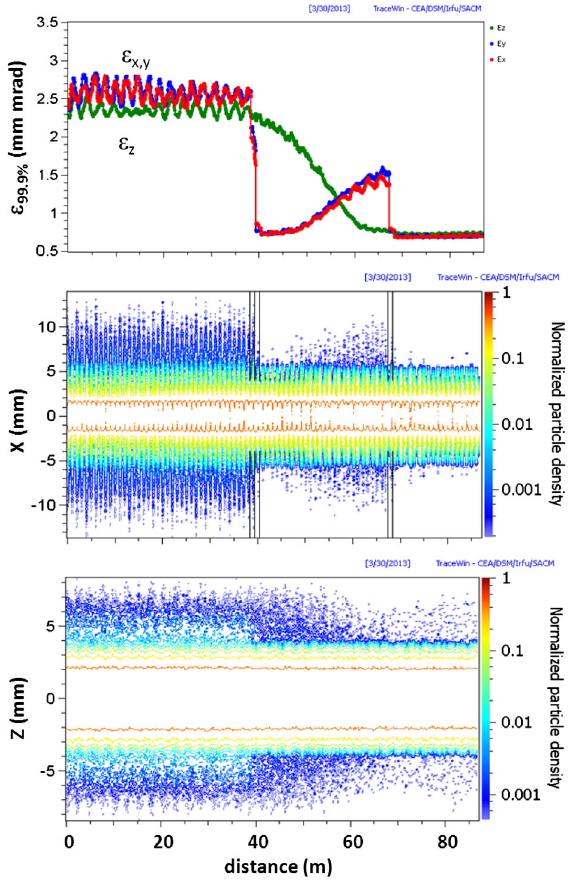
FIG. 6. Cleaning of initially isotropic halo by two consecutive transverse scrapers: 99.9% emittances (top); x evolution (center); and z evolution